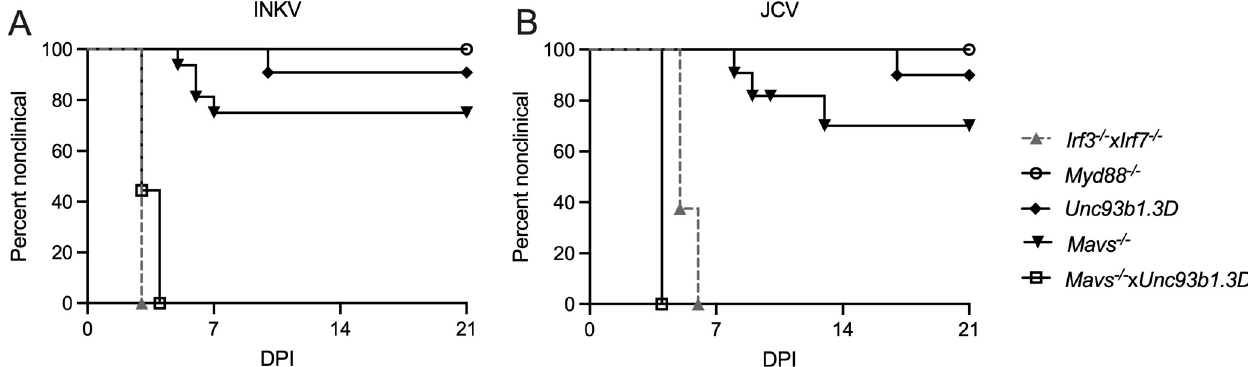
Fig 7. Disease curves in immune deficient mouse strains. Mice were inoculated IP with 10 5 PFU of A) INKV or B) JCV, and followed for neurological signs, other endpoint criteria, or death. For Irf3 -/- xIrf7 -/- n = 8 INKV and JCV; for Myd88 -/- n = 5 INKV, n = 8 JCV; for Unc93b1 .3D n = 11 INKV, n = 10 JCV; for Mavs -/- n = 14 INKV, n = 10 JCV; for Mavs -/- xUnc93b1 .3D n = 9 INKV, n = 10 JCV.